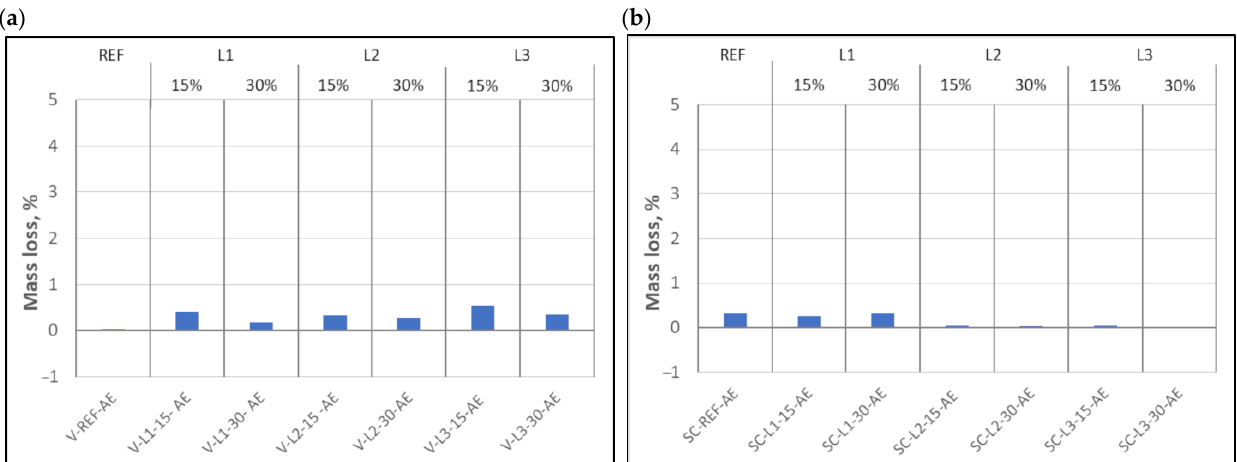
Figure 5. Mass loss of ( a ) vibrated and ( b ) self-compacting concrete with air-entraining admixture after 100 freeze – thaw cycles.